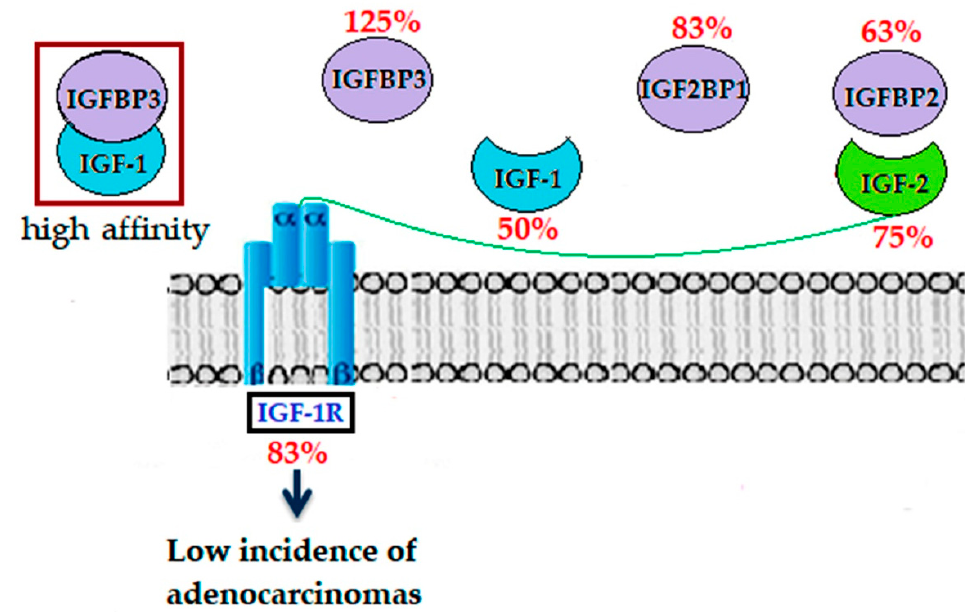
Figure 4. Modulation of the IGF system by BF + LYC 20 in AOM-DSS-treated mice. Restored IGFBP3 expression levels might bind with high affinity to IGF-1, leading to subsequent activation of the signaling pathways by IGF-2 and its binding to IGFBP2, as a result, the low incidence of adenocarcinomas is showed. The percentages in red represent the positive rates expressed in Figure 3.